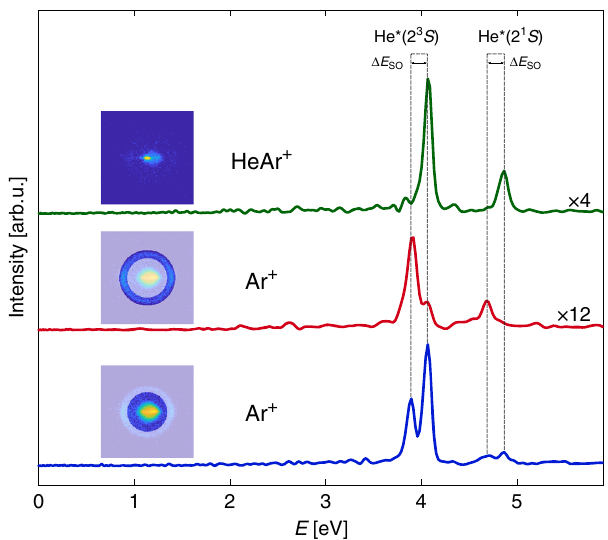
Fig. 4 Electron energy distributions. Energy distributions of Penning electrons related to Ar + with radial velocity between 0 and 209 m/s (blue curve), Ar + with radial velocity between 209 and 295 m/s (red curve), and HeAr + (green curve). The related ionic VMI images are presented above each